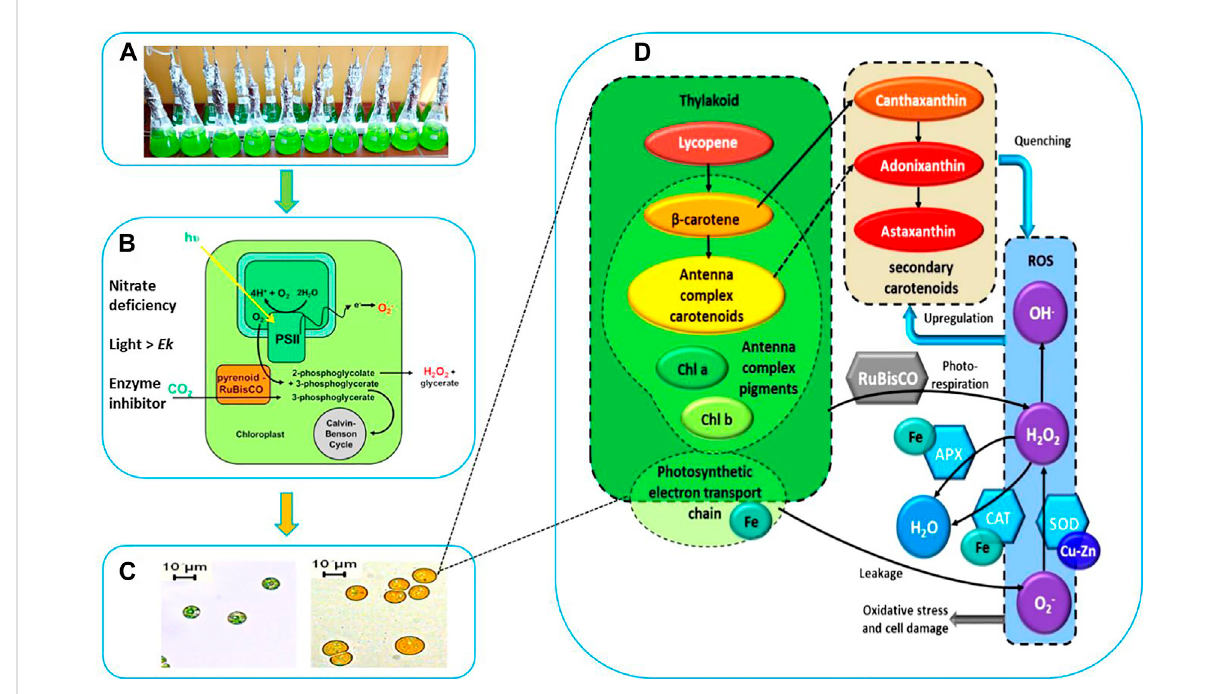
FIGURE 1 SchematicRepresentationofStressedCultivationwithEnzymeInhibitorAddition. (A) StressedcellcultivationatT=0(inoculation). (B) Stressed conditions to induce carotenogenesis. (C) Microscopic observation of cell morphology and cellular pigments evolution. (D) Proposed interaction between the cofactors (Fe, Cu), antioxidant enzymes catalase (CAT), superoxide dismutase (SOD), ascorbate peroxidase (APX), the reactive oxygen species (ROS), the photosystem and the high-valued secondary carotenoids (canthaxanthin, astaxanthin, and adonixanthin).